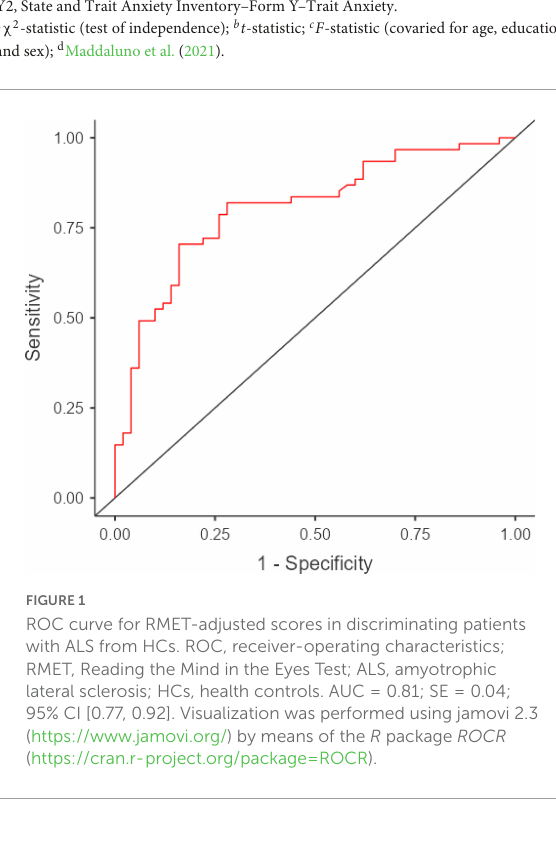
(PPV = 0.39; NPV = 0.97; LR+ = 2.33; LR − = 0.13) at the optimal cutoff ( < 23; J =